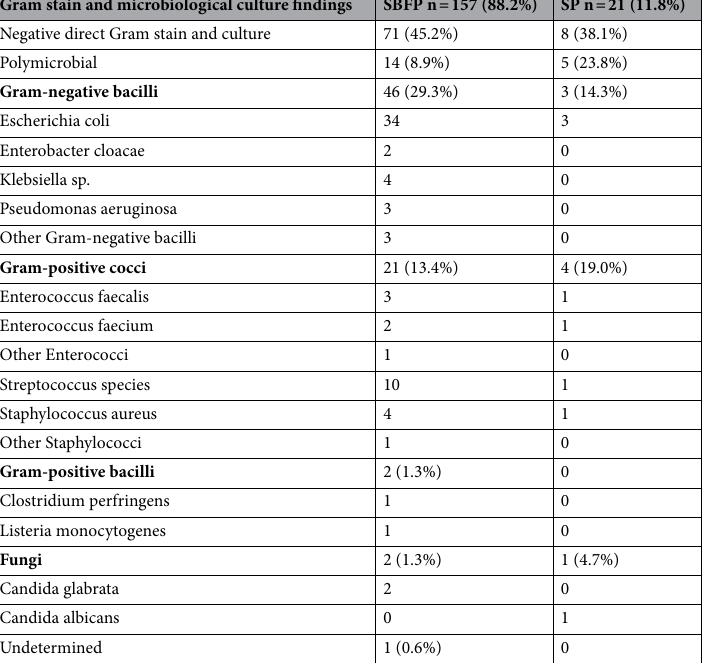
Table 2. Gram stain and microbiological culture findings in ascitic fluid samples from 178 patients with cirrhosis and spontaneous bacterial/fungal peritonitis (SBFP) or secondary peritonitis (SP). SBFP spontaneous bacterial/fungal peritonitis, SP secondary